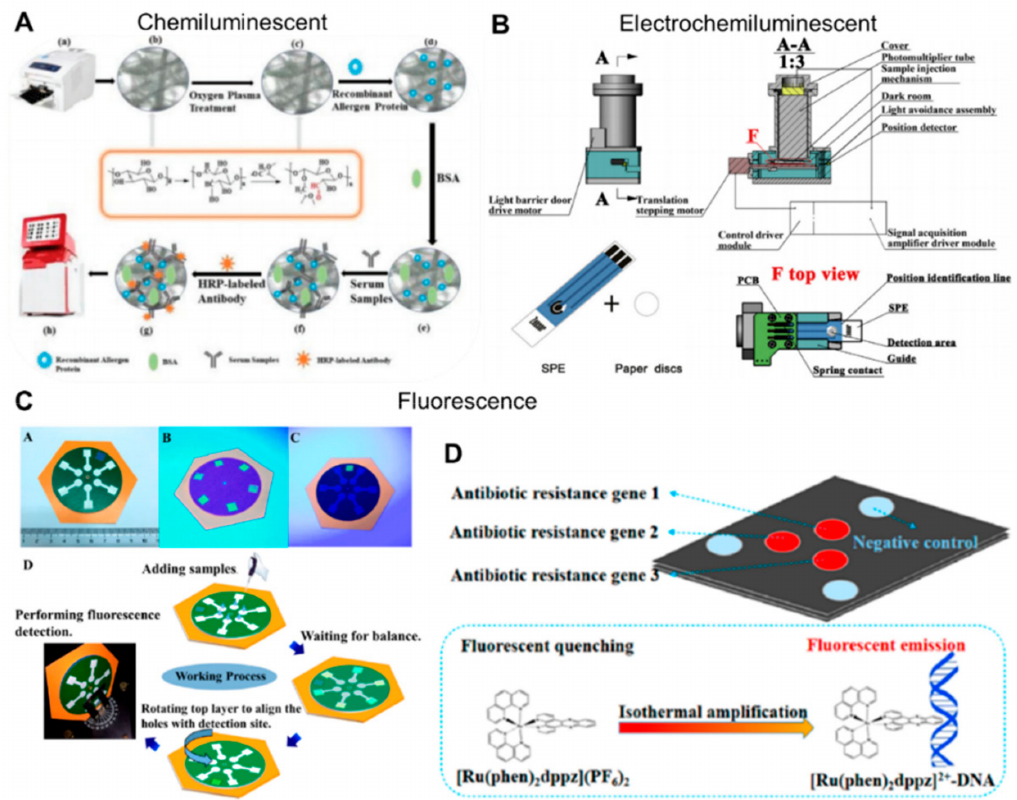
Figure 8. Detection techniques and recent applications of µ PADs. ( A ) Chemiluminescent detection